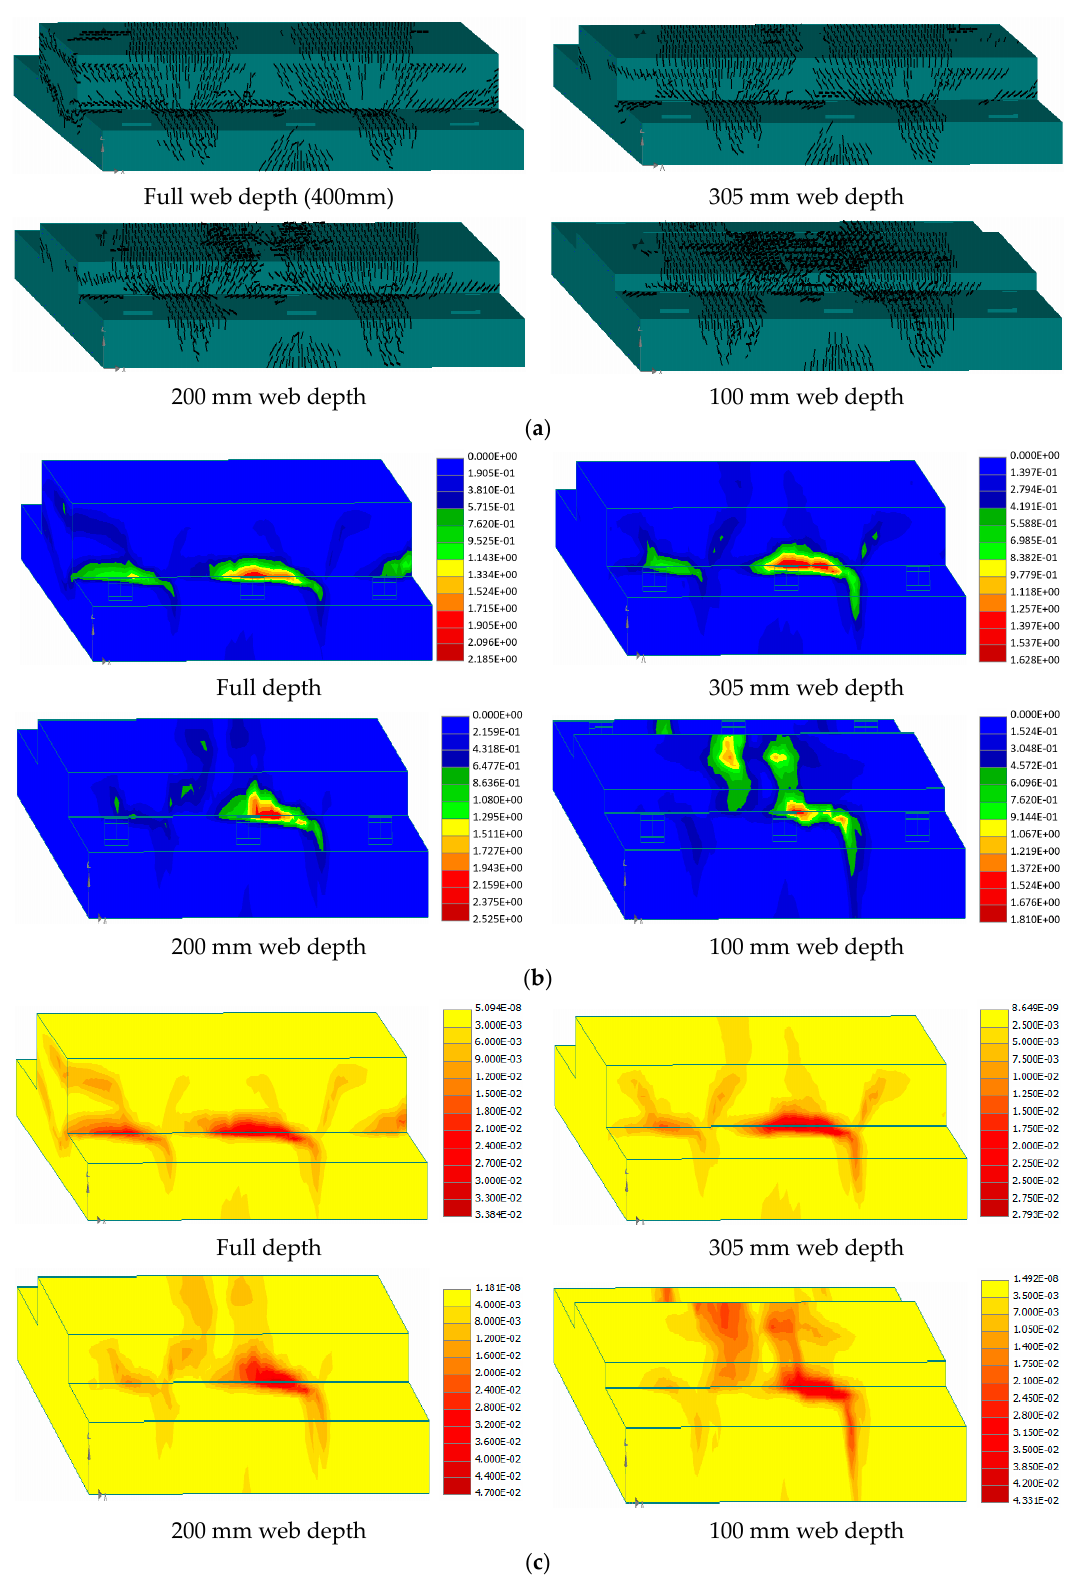
Figure 15. Crack patterns, crack width, and principal tensile strain of 45 ◦ skewed beam: ( a ) Crack pattern (45 ◦ skew); ( b ) Crack width (45 ◦ skew); ( c ) Principal tensile strain (45 ◦